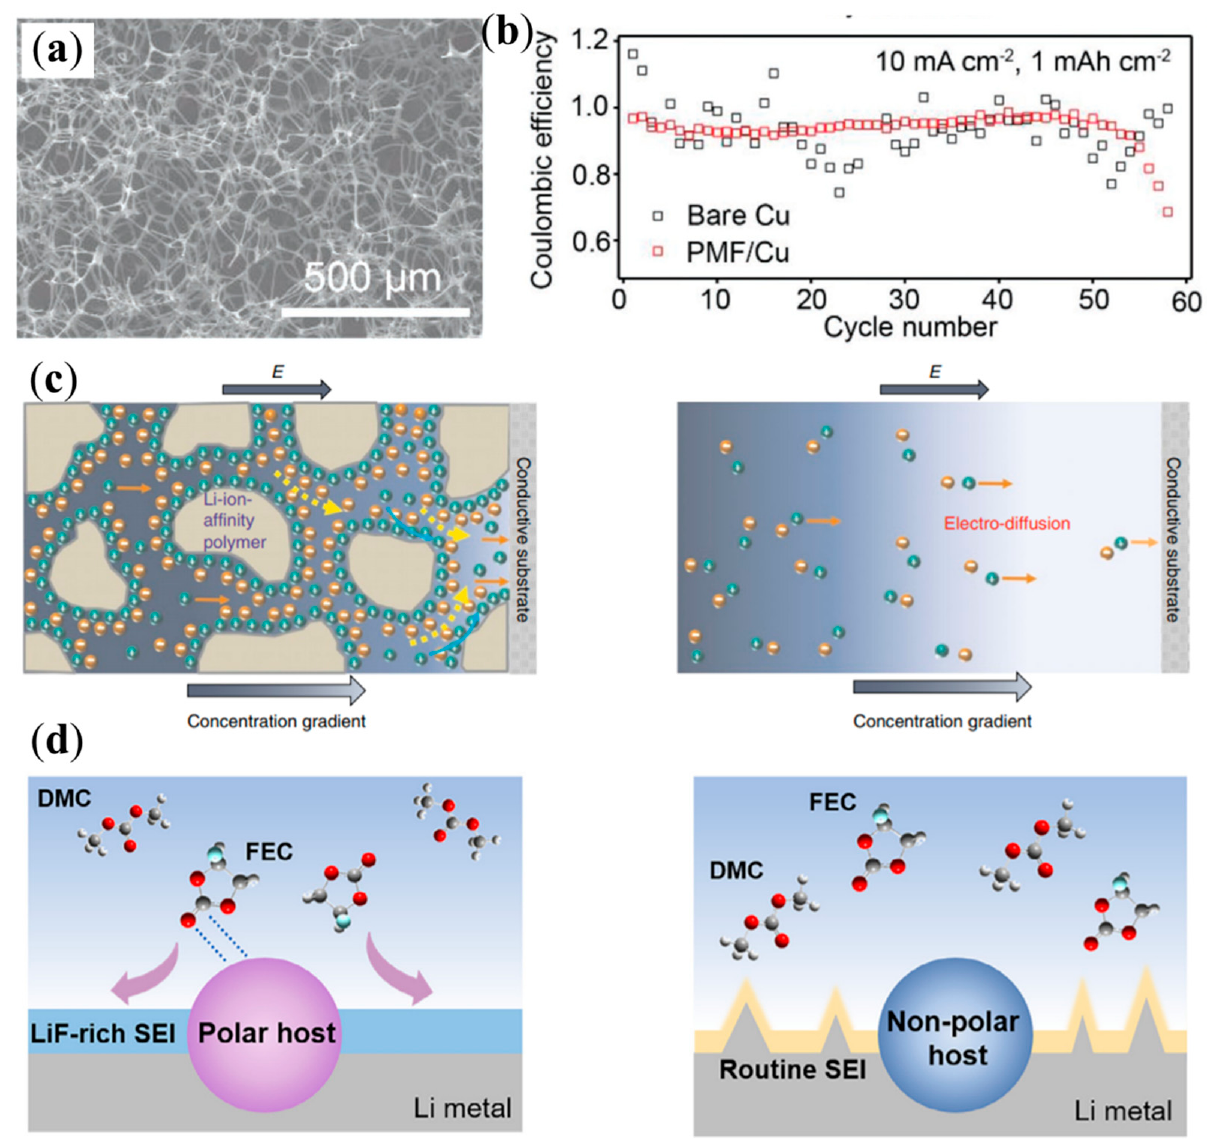
Figure 8. ( a ) SEM image of 3D PMF; ( b ) Lithium Coulombic efficiencies at 10 mA cm − 2 , 1 mA h cm − 2 Figure [89] . Copyright © 2022, WILEY-VCH. ( c ) Electrodiffusion of Li ions in 3D PSS and traditional cells under an electric field, the green ball represents cations and the orange balls represent anions, respectively [99] . Copyrights © 2022, Springer Nature. ( d ) Molecular interactions between the polymer host and solvent in a composite Li anode are shown schematically [95] . Copyrights © 2022, ELSEVIER.